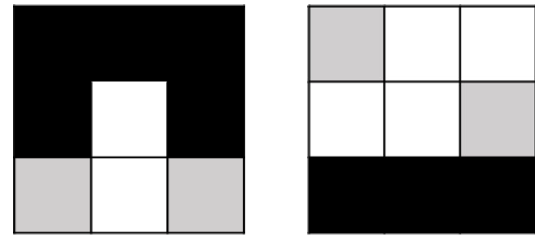
Figure 10. Structure elements.